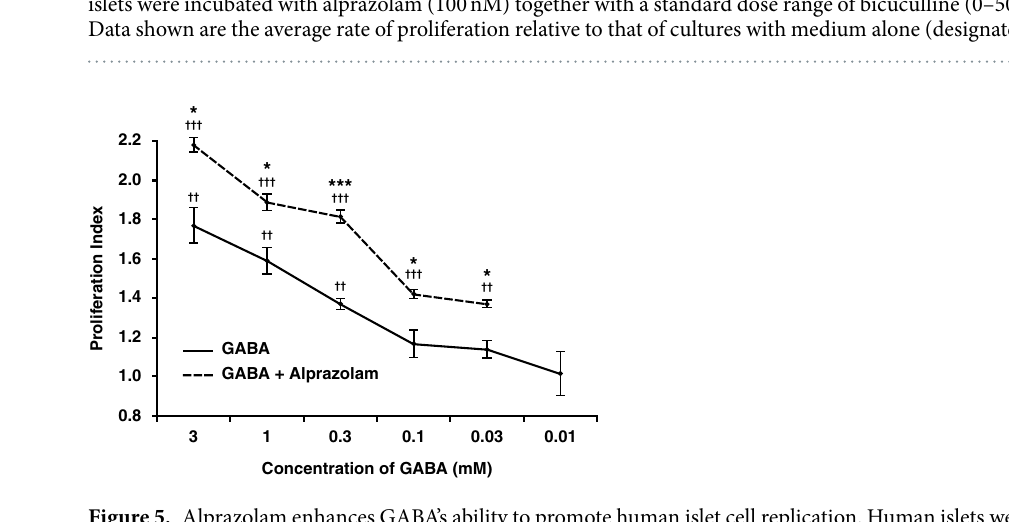
Figure 5. Alprazolam enhances GABA’s ability to promote human islet cell replication. Human islets were incubated with a dose range of GABA together with alprazolam (100 ng/ml) for 4 days in the presence of 3 H thymidine. Data shown are the average rate of proliferation relative to that of cultures with medium alone (designated as 1) in a representative study. N = two independent studies with triplicate cultures. The results were very similar in both studies. †† p < 0.01 and ††† p < 0.001for GABA, or GABA + alprazolam vs. control medium alone; * p < 0.05 and *** P < 0.01 for GABA + alprazolam vs. GABA alone, determined by Student